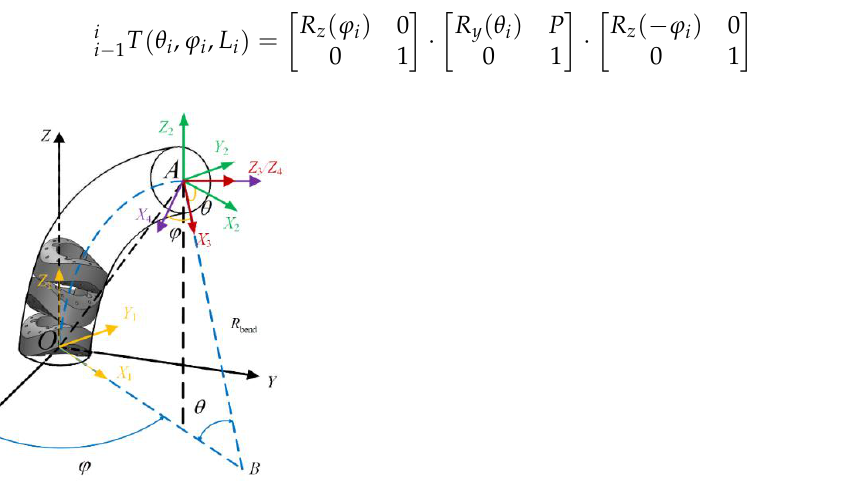
Figure 6. Pose transformation based on the constant curvature model.